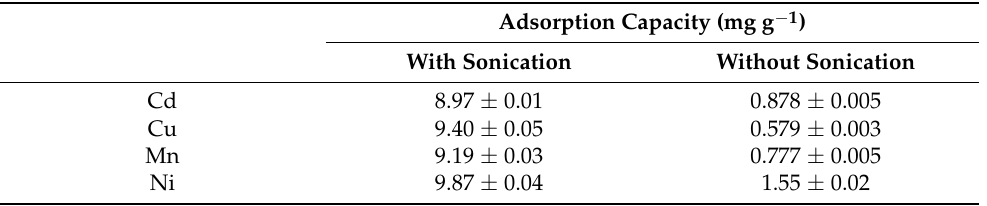
Table 1. Effect of sonication on the adsorption of Cd, Cu, Mn and Ni.